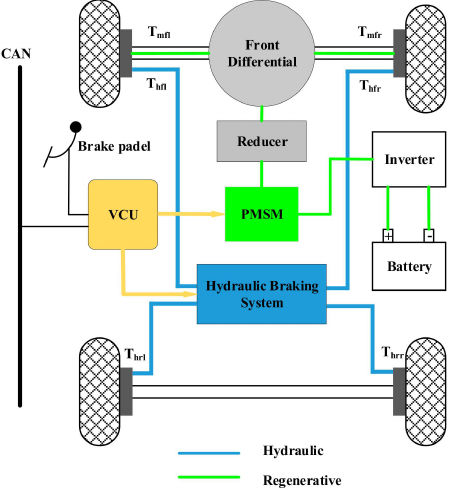
Figure 1. Block diagram of electro-hydraulic composite braking system of the test electric